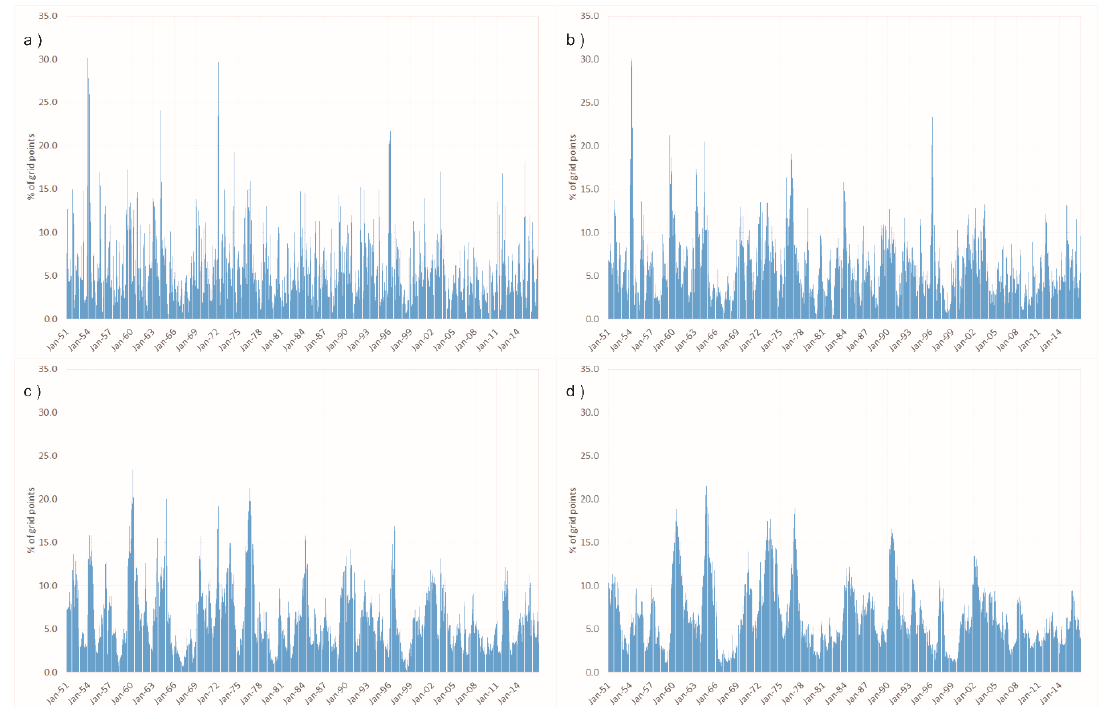
Figure 2. Temporal evolution of the percentage of grid points which fell within severe or extreme dry conditions (Standardized Precipitation Index SPI < −1 .5) for the period 1951 – 2016. ( a ) 3-month SPI; ( b ) 6-month SPI; ( c ) 12-month SPI, and ( d ) 24-month SPI.